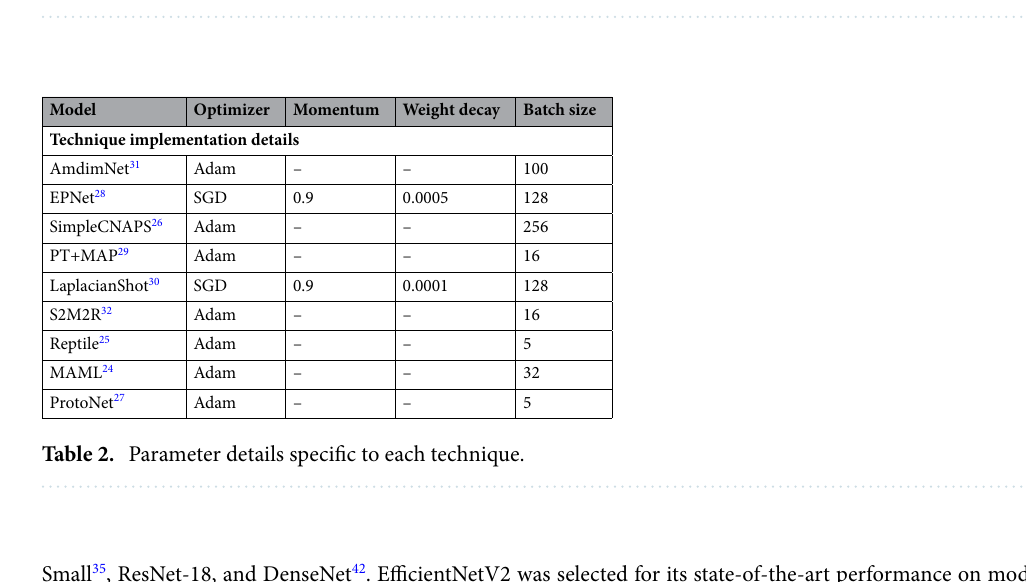
Table 1. An overview of the differing details between the models trained and tested.